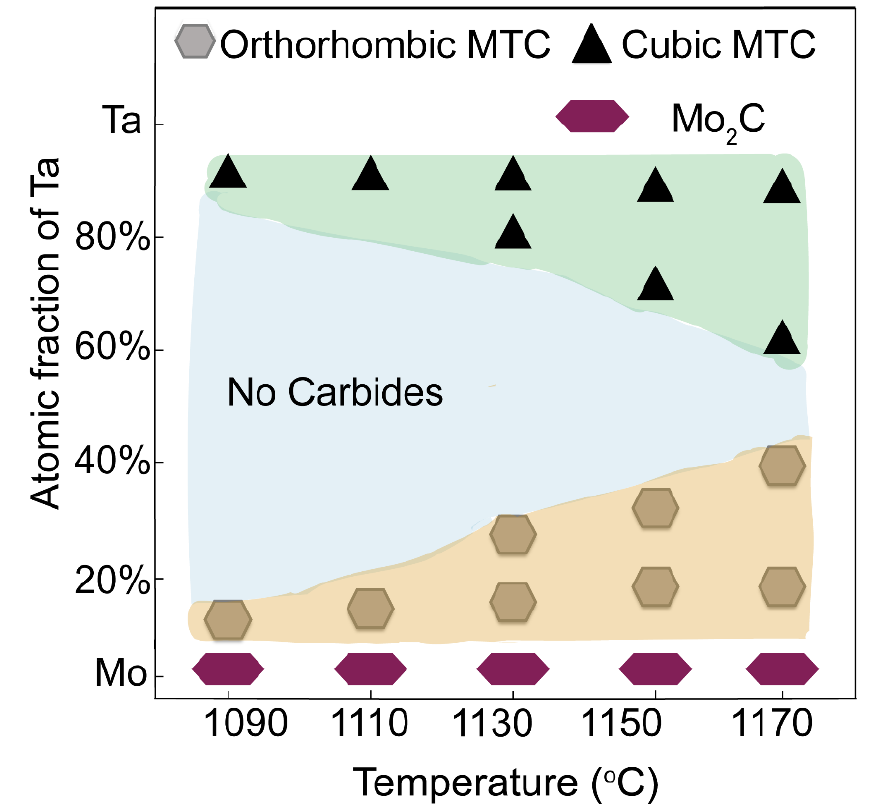
Figure 5. Effect of temperature and Mo/Ta atomic fraction on the growth of orthorhombic and cubic MTC.